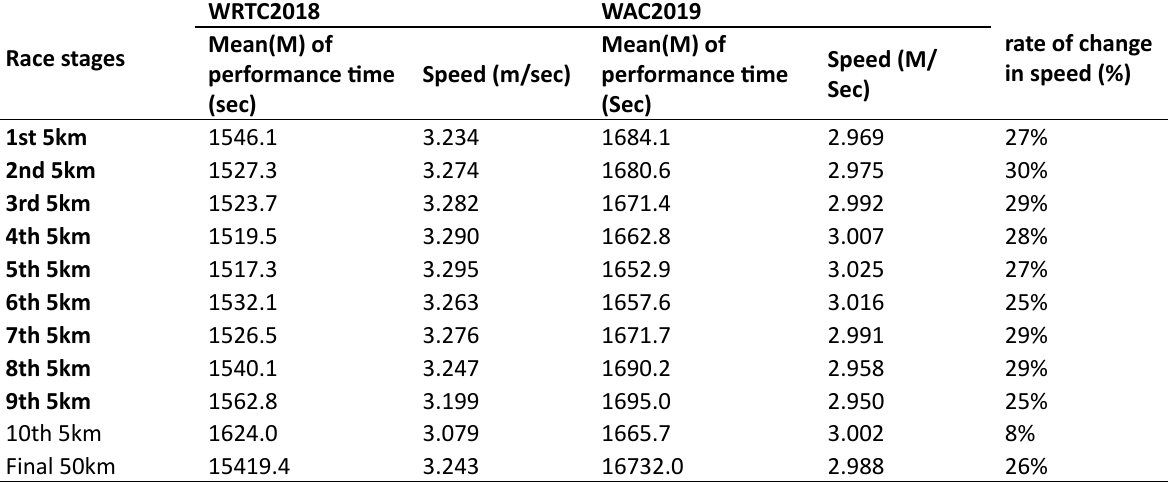
Table 4. Rate of change in speed (%) between both Championships for each